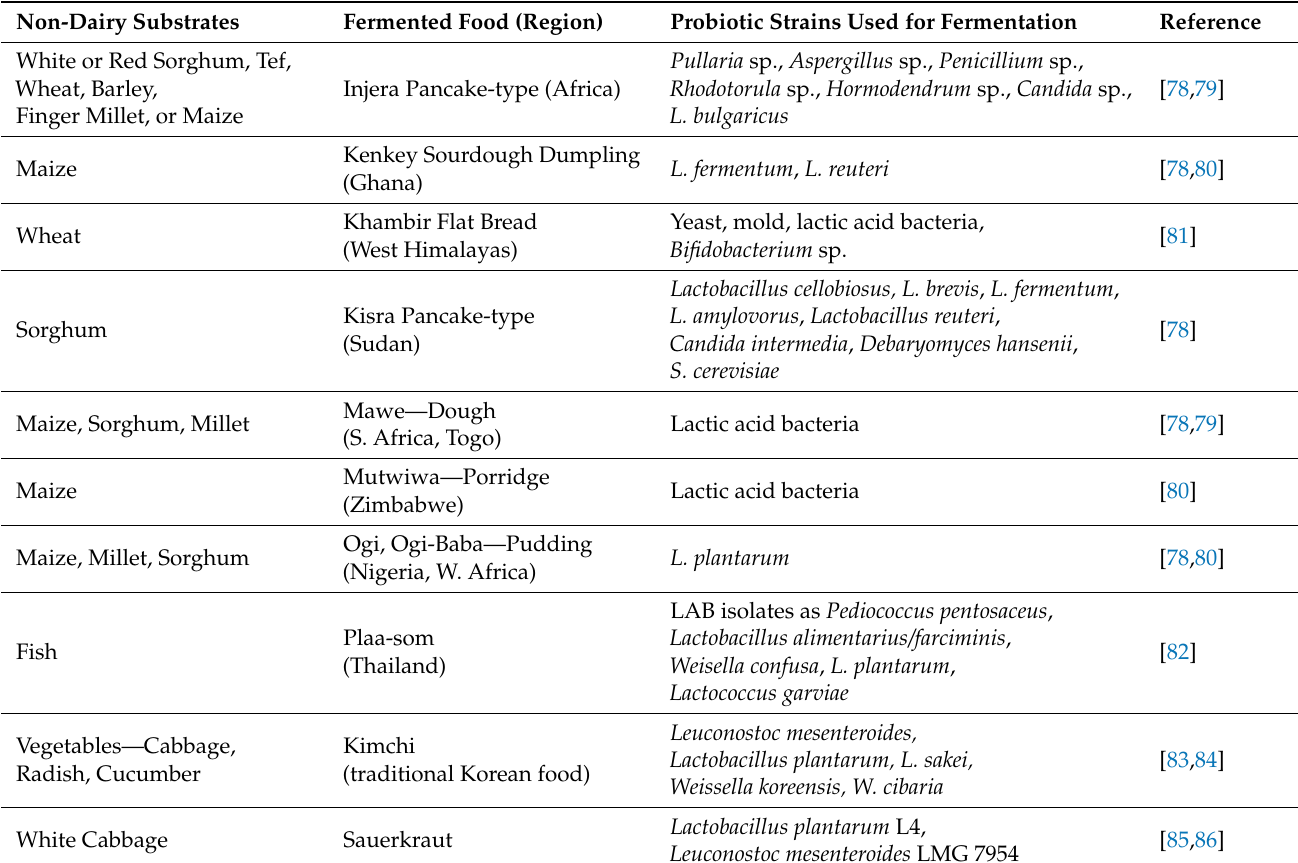
Table 4. Traditional foods with probiotic properties from fermentation of non-dairy